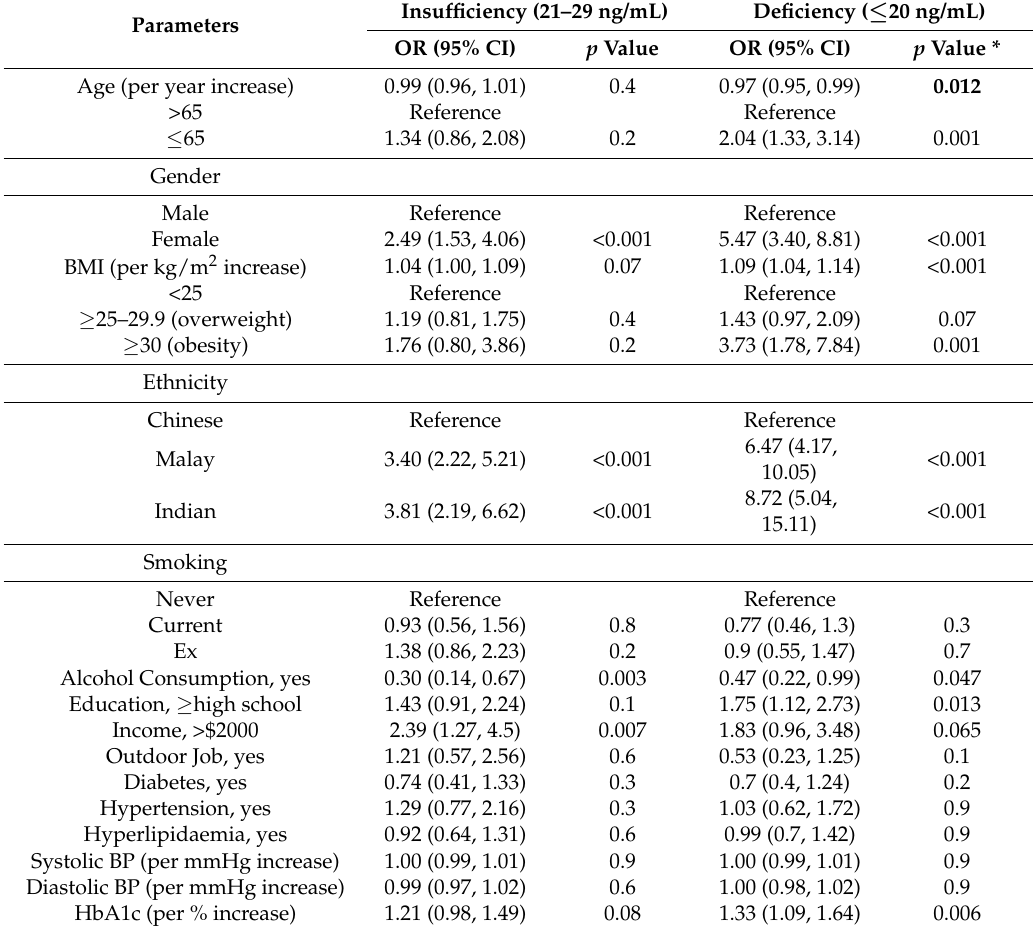
Table 4. Multivariable adjusted associations of clinical, demographic and lifestyle parameters with 25(OH)D insufficiency and